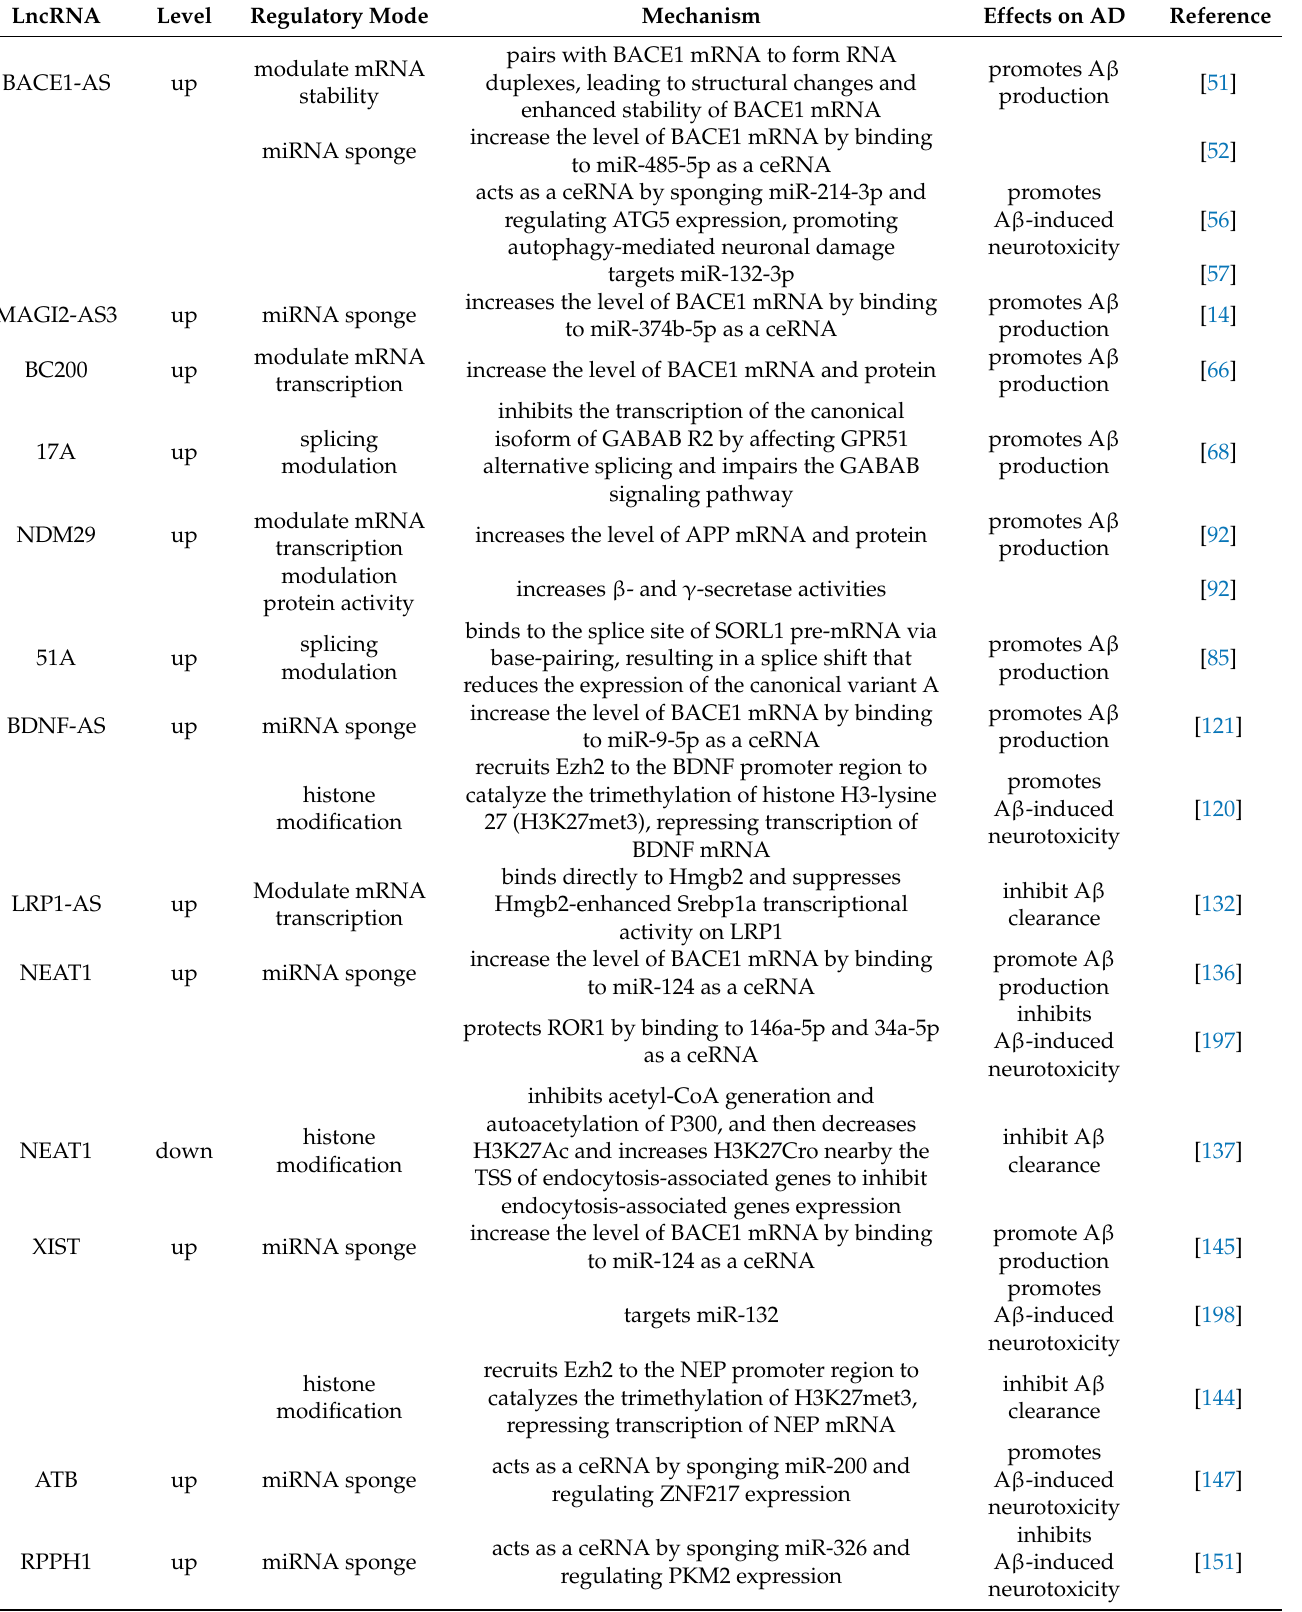
Table 1. Aberrant expression patterns of various lncRNAs involved in A β cascade